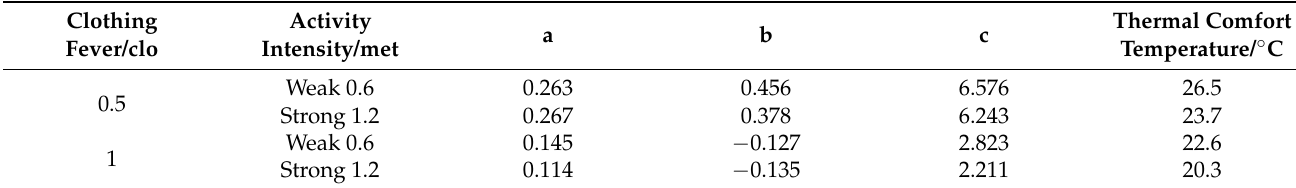
Table 2. Thermal comfort model parameters of users.